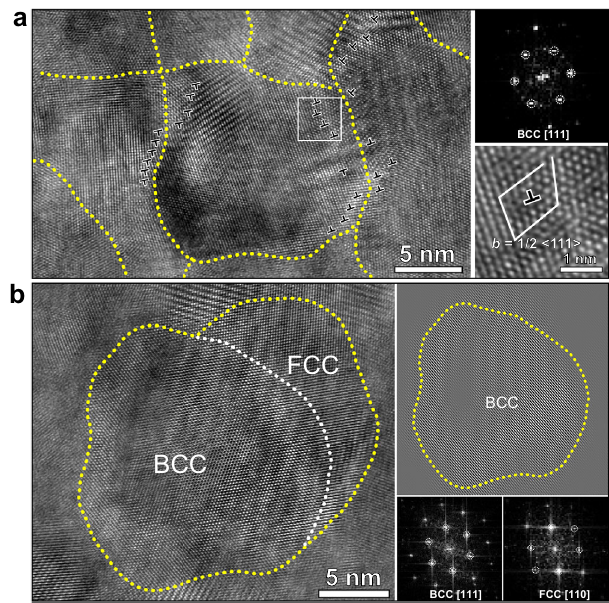
Fig. 4 | HRTEM observations of the IGC nanograined Fe-Ni samples before and afterannealingat300°Cfor1h.a Thisshowsthedislocations(markedbyTshape symbols)atthe grainboundary region (markedbythe dottedyellow line), FFTand a typical burgers circuit of the Fe-Ni sample before annealing. b HRTEM image of the300°CannealedFe-Nisample,showingthecoexistenceofBCC(electronbeam is along the [111]) and FCC (electron beam is along the [110]) phases, and a dislocation-free